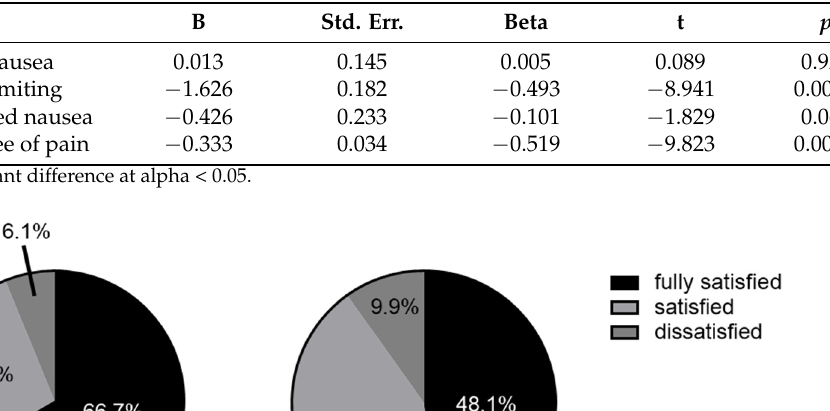
Table 5. Analysis of the factors related to nursing satisfaction.